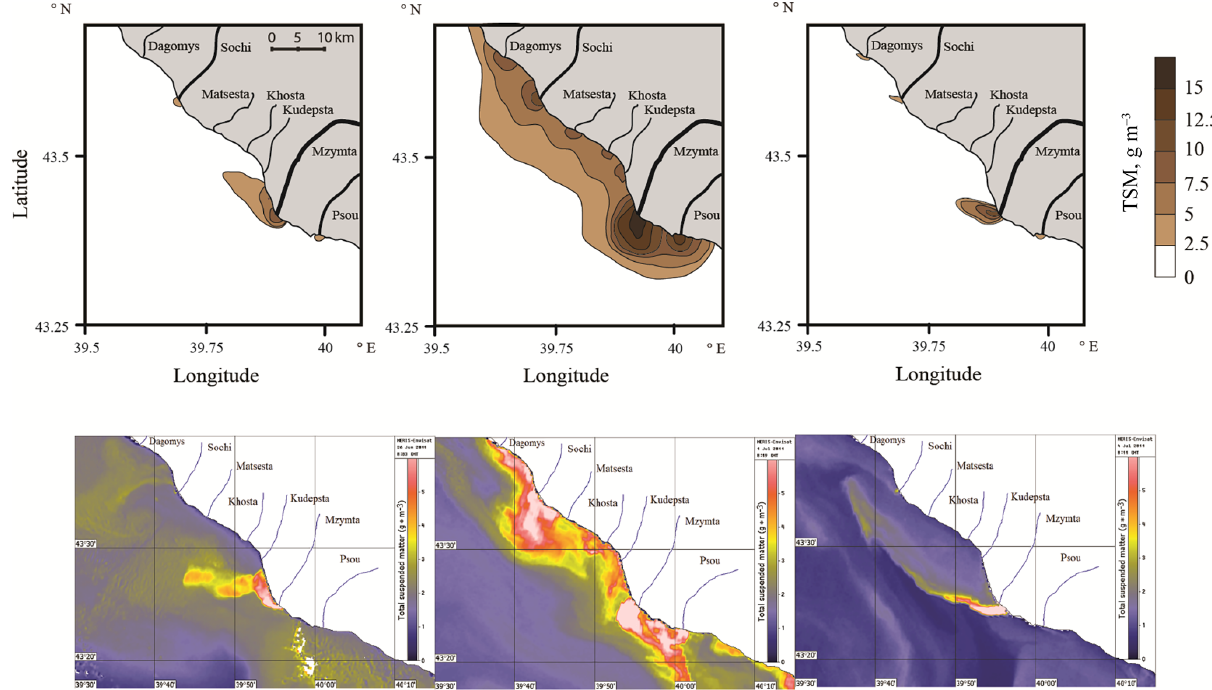
Figure 11. Modeled real mode (top panel) and satellite-derived (bottom panel) surface TSM distributions at the southern part of the study region on 26 June, 1 July, and 4 July